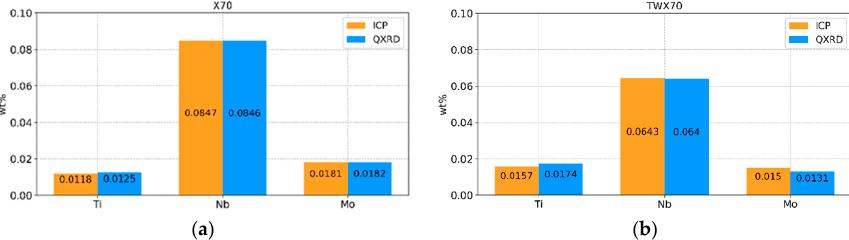
Figure 11. Comparison of Ti, Nb, and Mo amounts in precipitates for ICP and QXRD for ( a ) X70 steel and ( b ) TWX70